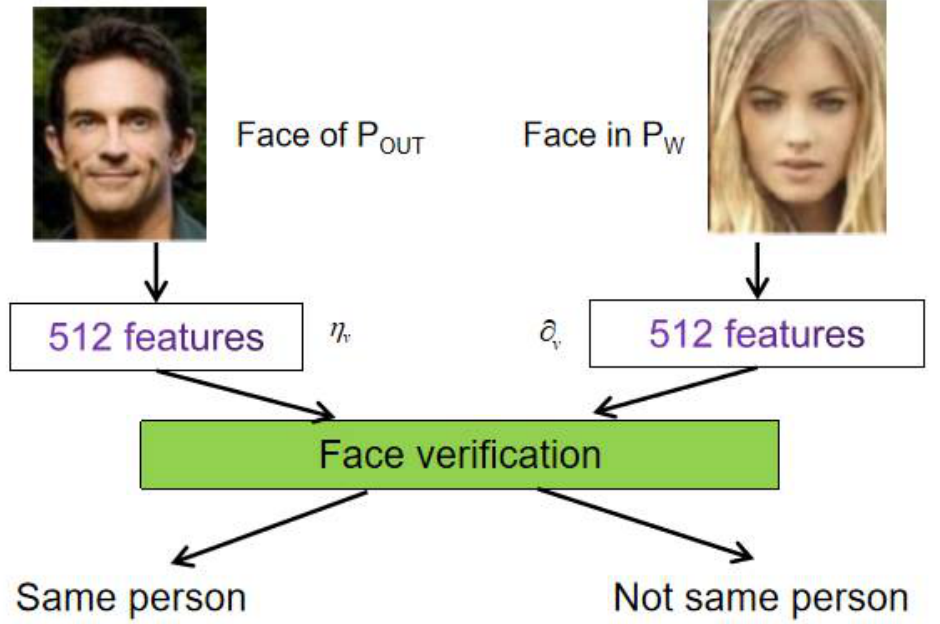
Figure 7. Module of face